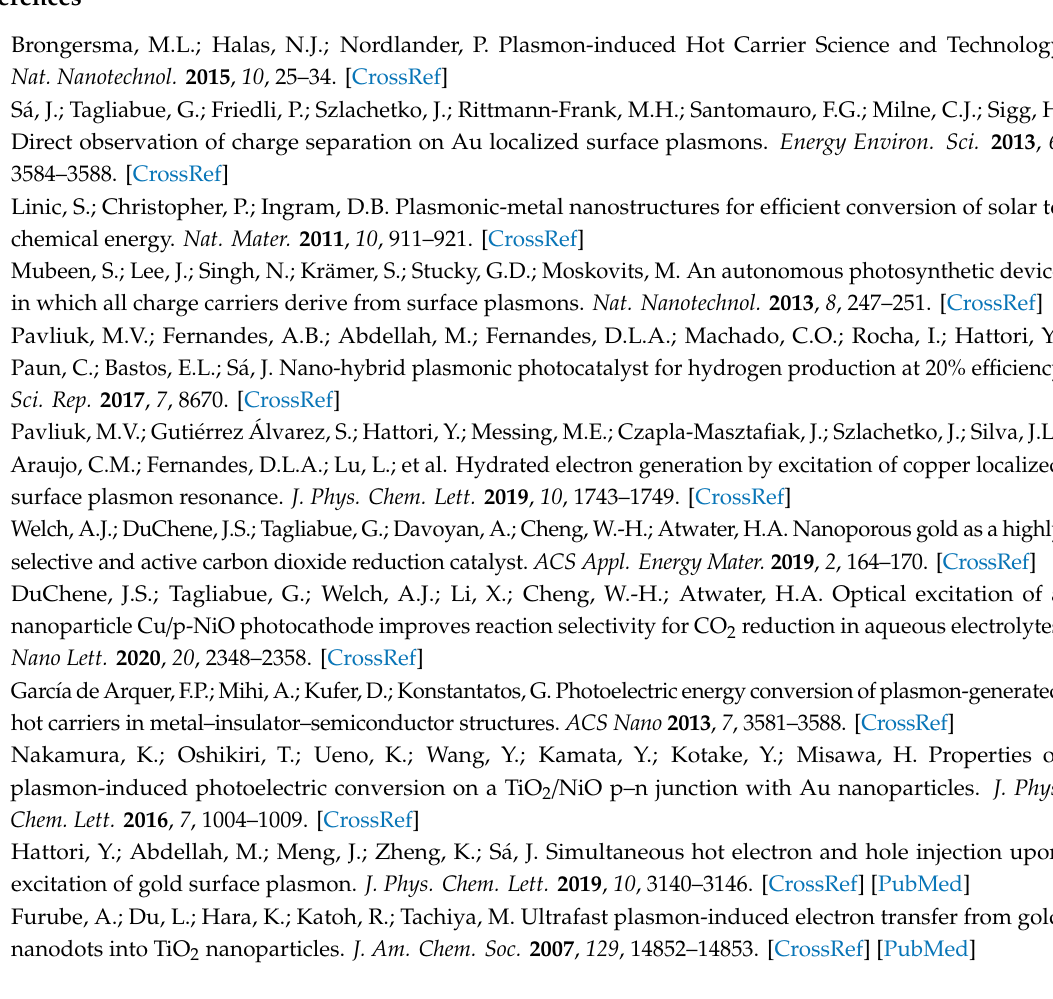
Figure S1: Dynamic light scattering (DLS) of Ag NPs (black trace), and Ag-pABA (red trace). Figure S2: FTIR spectra of pABA (red trace), Ag NPs (black trace), and Ag-pABA (purple trace). The fit peak (blue trace) was obtained from deconvolution, showing COO- symmetric stretching. Figure S3: FTIR spectra of Ag NPs (black trace) along with sodium citrate (violet trace), and glycerol (cyan trace). Even after washing, the signal from glycerol is present in Ag NPs. Figure S4: UV-Vis spectra of TiO 2 (black dashed trace), pABA (purple trace) and pABA on TiO 2 (green trace). Figure S5: FTIR spectra of Ag-pABA-TiO 2 (dark yellow), and Ag-pABA (purple trace). Figure S6: Temporal evolution of the UV-Vis spectra of the catalytic reaction using Ag-pABA- TiO 2 (10 µ g / mL) and 405 nm laser excitation. Spectra recorded over 60 min. Figure S7: The disappearance rate of 4-NP using bare TiO 2 , with laser